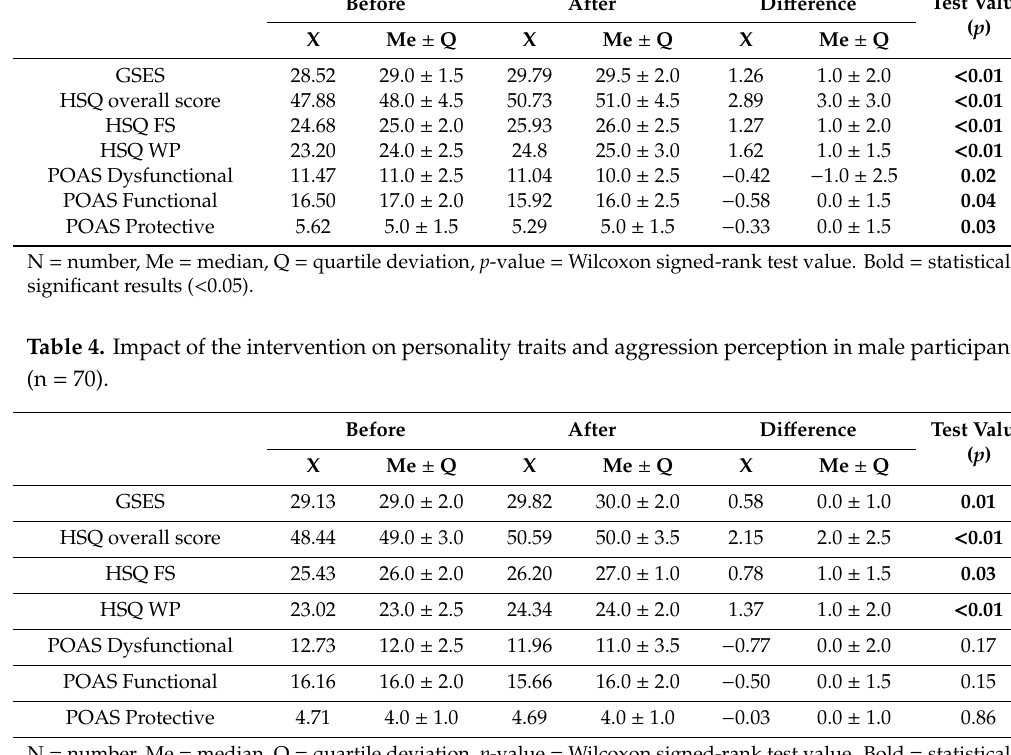
Table 3. Impact of the intervention on personality traits and aggression perception in female participants (n = 206). Before After